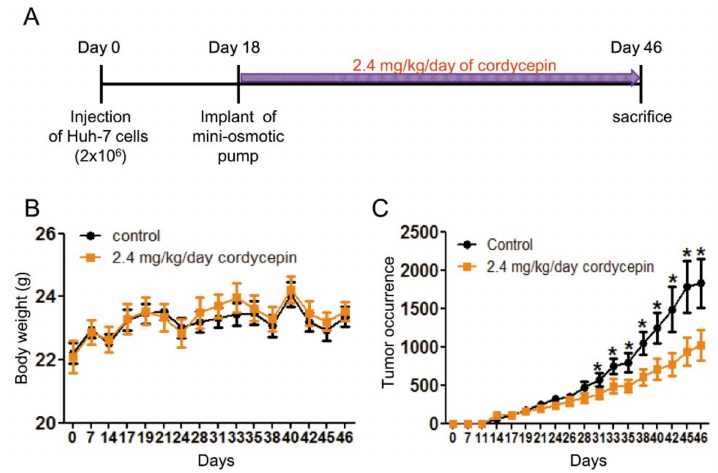
Figure 6. Reduction of in vivo HCC tumor growth by cordycepin. ( A ) An outline of the experimental procedure. Micro-osmotic pumps delivering either the control (DMSO) or cordycepin were implanted subcutaneously into nude mice 18 days after the injection of Huh-7 cells. The ( B ) body weight and ( C ) tumor volume of nude mice ( n = 9) were assessed. *, p <